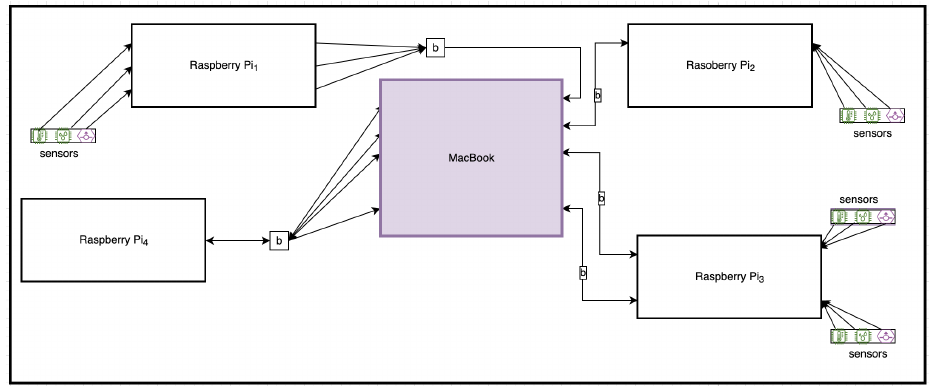
Figure 6. SecIoTComm Implementation